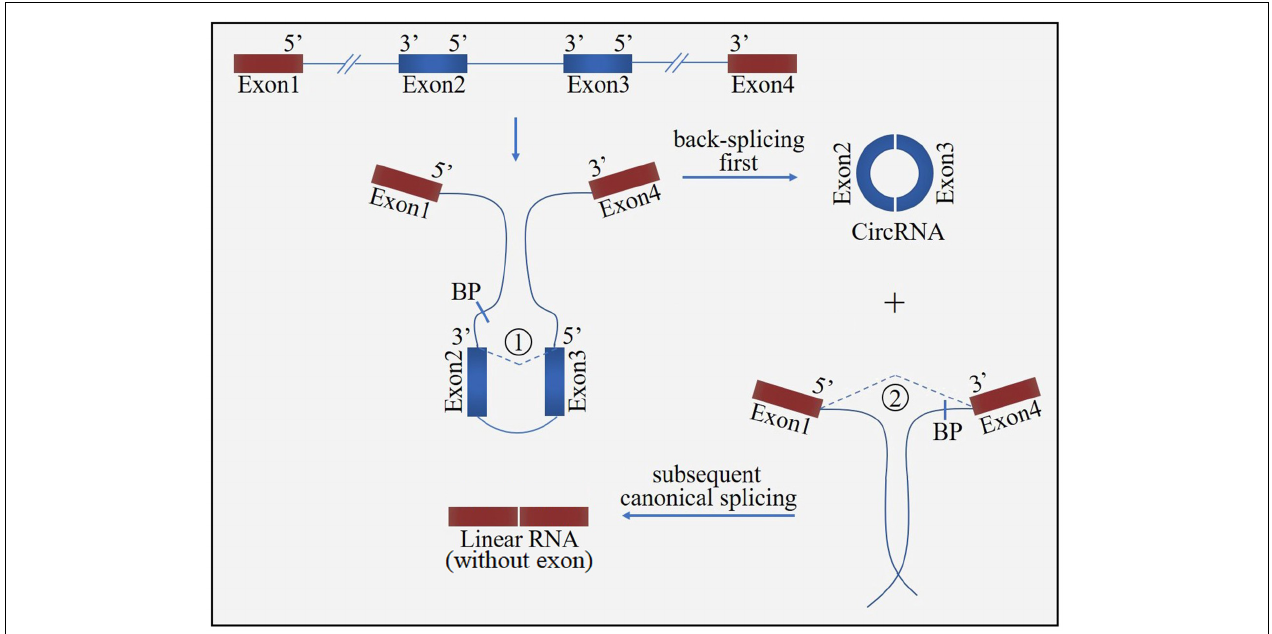
FIGURE 3 | The “direct back-splicing” model for circRNA formation. The process starts with back-splicing for a circRNA (exon2 and exon3) together with an exon-introns-exon intermediate, which further form a linear RNA (exon1 and exon4) with skipped exons. BP,